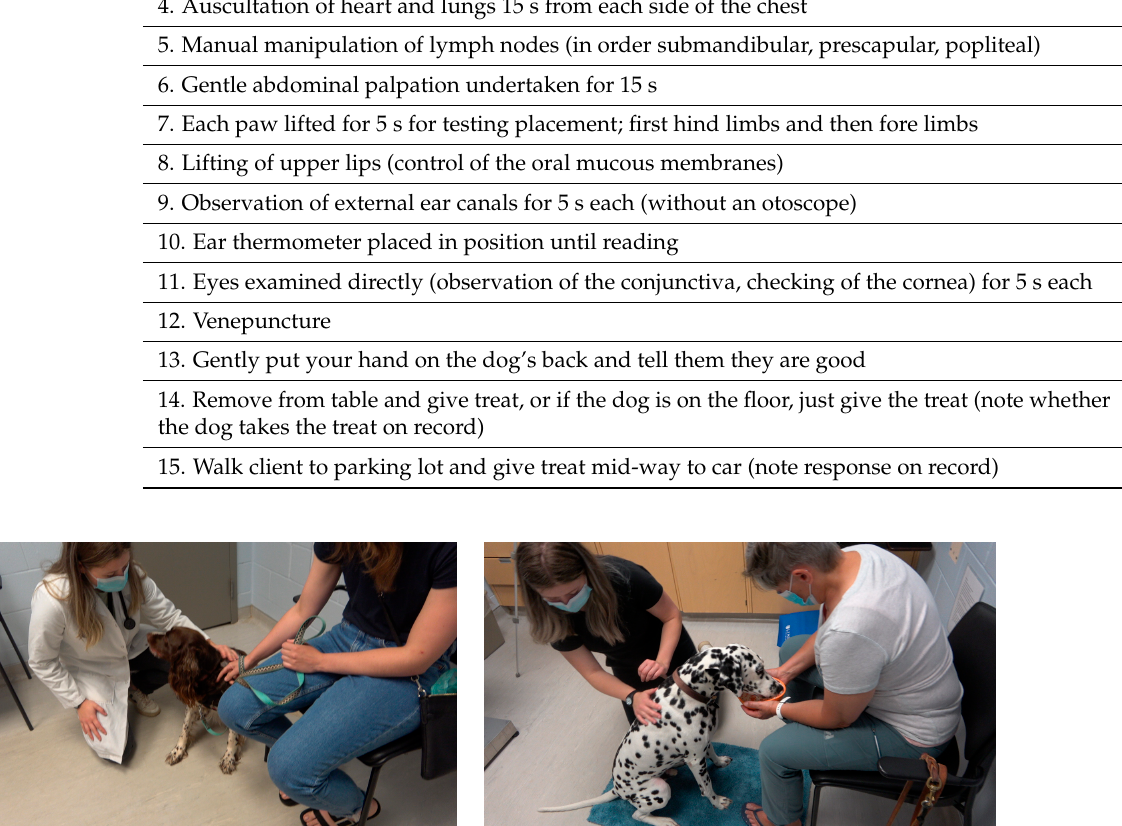
Figure 4. ( a ) Blood collection example for control group and ( b ) intervention group.